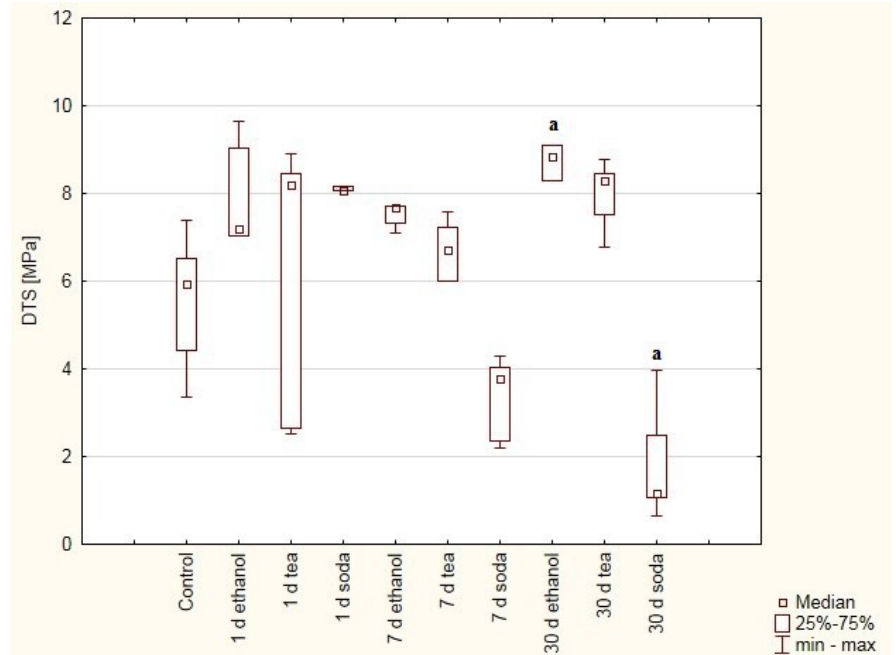
Figure 5. Box and whiskers plot of diametral tensile strength (DTS). Values were obtained for samples made of IHDENT Giz typ II cement treated with ethanol (75%), green tea and baking soda (2.5%) solutions after one, seven or 30 days and samples immersed for seven days in distilled water as control. Significant statistical differences were detected between: (a) 30 days in ethanol solution vs. 30 days in soda solution.